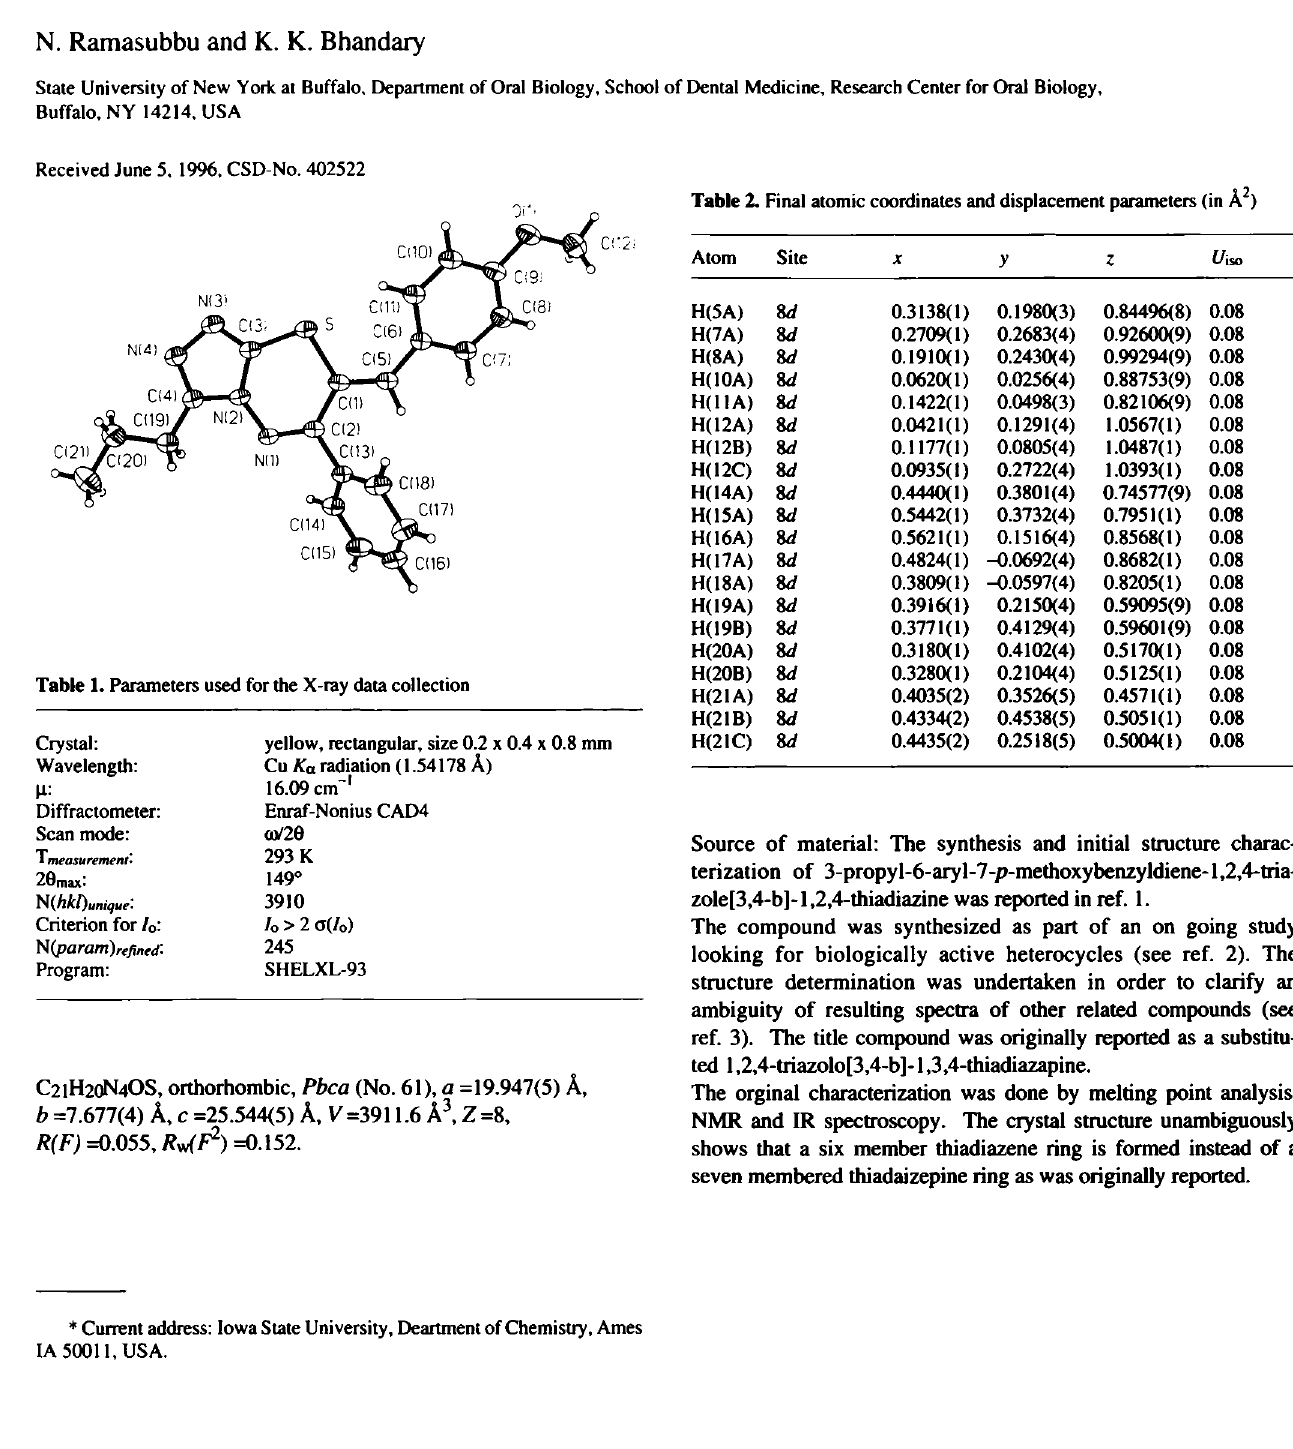
Table 2. Final atomic coordinates and displacement parameters (in A 2